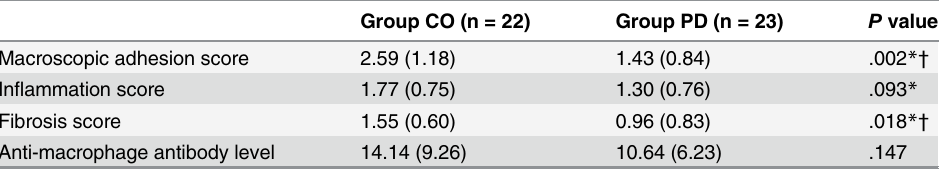
Table 3. Macroscopic and Microscopic Adhesion